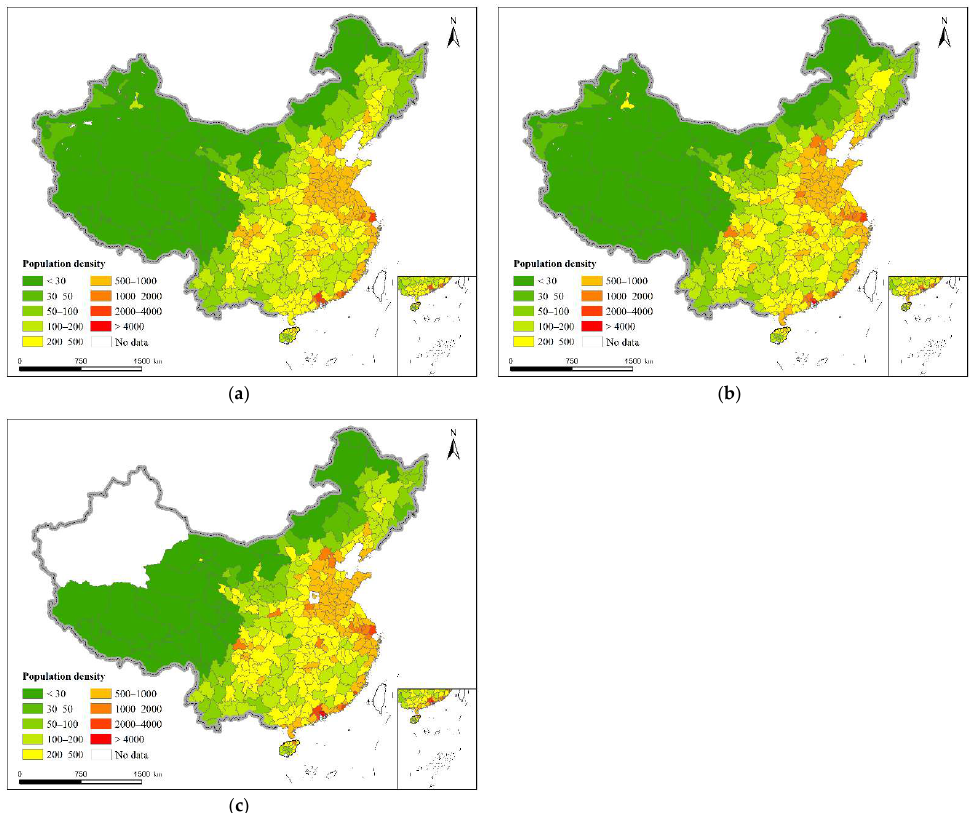
Figure 4. Population density maps at 1 km spatial resolution for ( a ) 2000, ( b ) 2010, and ( c ) 2020. Based on the 1 km population density distribution, the average population density for urban level (Figure 5) and provincial-level regions (Figure 6) in China were obtained. The results show that the distribution of urban population density in China in 2000, 2010, and 2020 is similar, with an overall pattern of being high in the southeast and being low in the northwest. The population density of coastal cities in southeast China is signifi- cantly higher than that of other regions. Among them, the cities in the Pearl River Delta and Yangtze River Delta urban agglomerations have a relatively high concentration of high population density cities. In addition, the population density of cities in central China is significantly higher than that in western and northeastern China. The average popula- tion density distribution pattern at the provincial level in China in 2000, 2010, and 2020 is similar to that at the city level. The overall pattern is high in the southeast and low in the northwest.